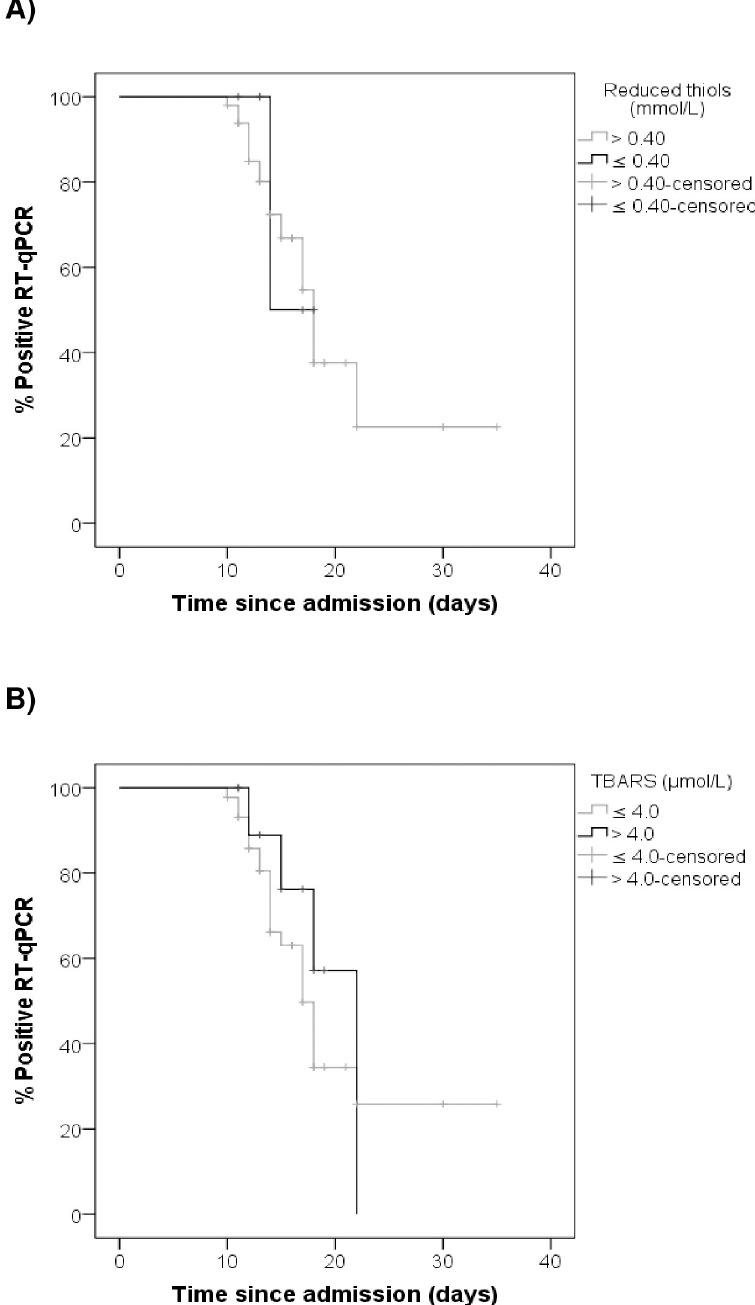
Fig 2. Survival analysis. Correlation between oxidative stress markers and time to a negative RT-qPCR. (A) Correlation of plasma levels of reduced thiols with time to a negative RT-qPCR. Log Rank (Mantel-Cox), P - value = 0.802; (B) Correlation of plasma levels of TBARS with time to a negative RT-qPCR. Log Rank (Mantel-Cox), P - value = 0.396. TBARS–Tiobarbituric acid reactive substances. % Positive RT-qPCR–Percentage of patients with a positive Real-time reverse transcriptase-polymerase chain reaction for SARS-CoV-2.